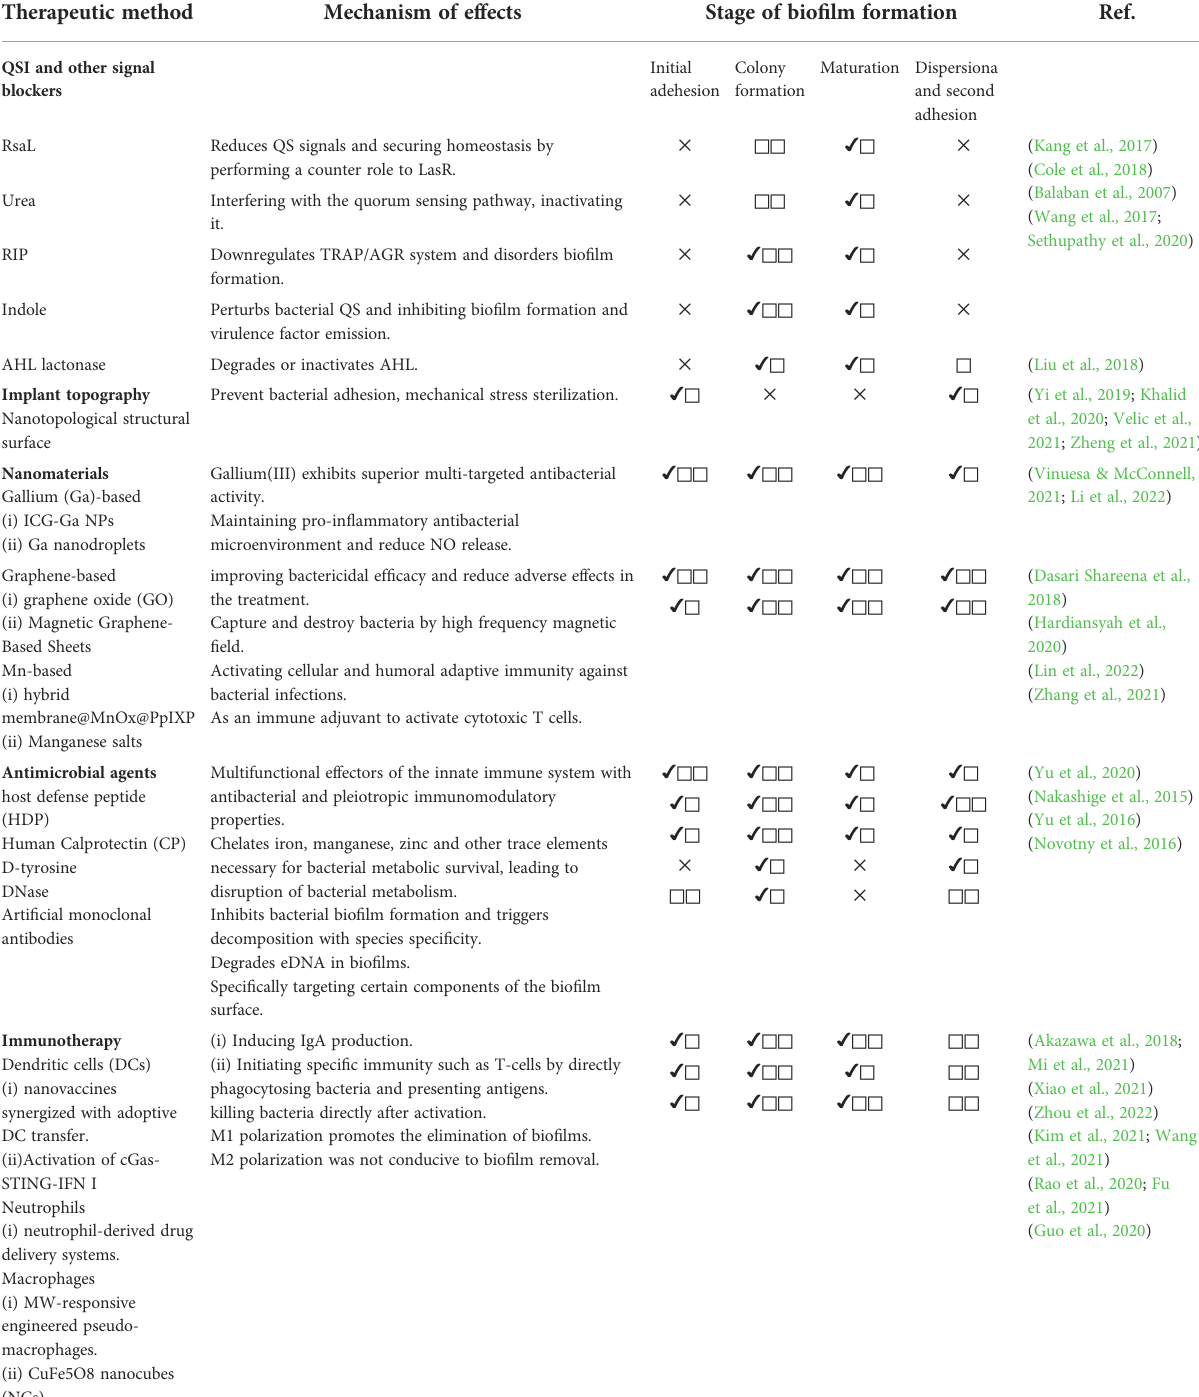
TABLE 3 Summary of therapeutic approaches to inhibit bio fi lm formation. Therapeutic